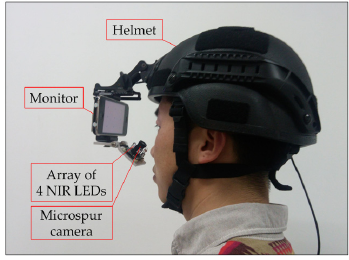
Figure 3. Wearable gaze tracking system. Appl. Sci. 2016 , 6 , 174